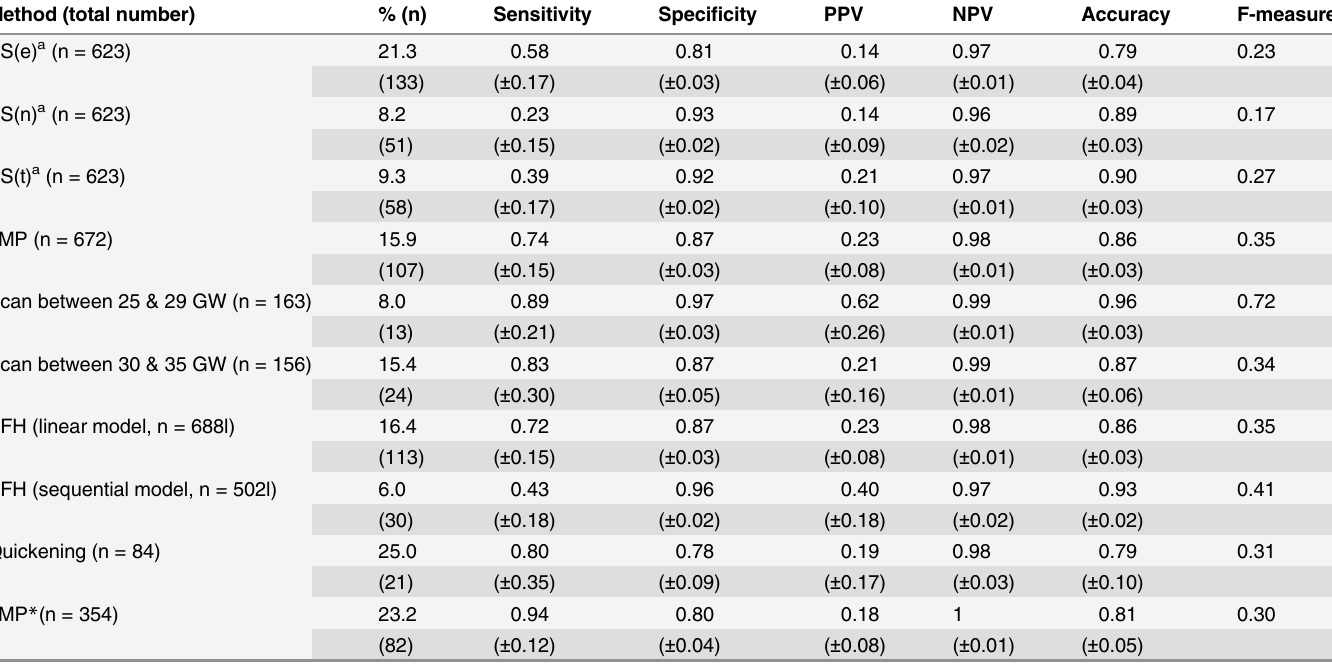
Table 4. Sensitivity and Specificity of Clinical and Late Ultrasound Estimates of Gestational Age against Gold-Standard Ultrasound to Predict Pre- term Birth in Comparison to the Reference Method (n = 688 with 5.2% (36) Diagnosed Preterm Birth). Method (total number) % (n) Sensitivity Speci fi city F-measure BS(e) a (n = 623)